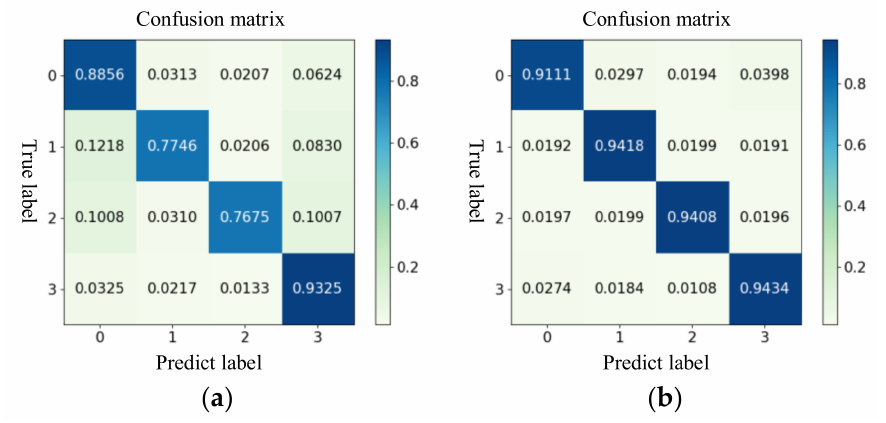
Figure 11. Comparison of FDIA detection results before and after data balance processing. ( a ) Before data balance processing; ( b ) after data balance processing.